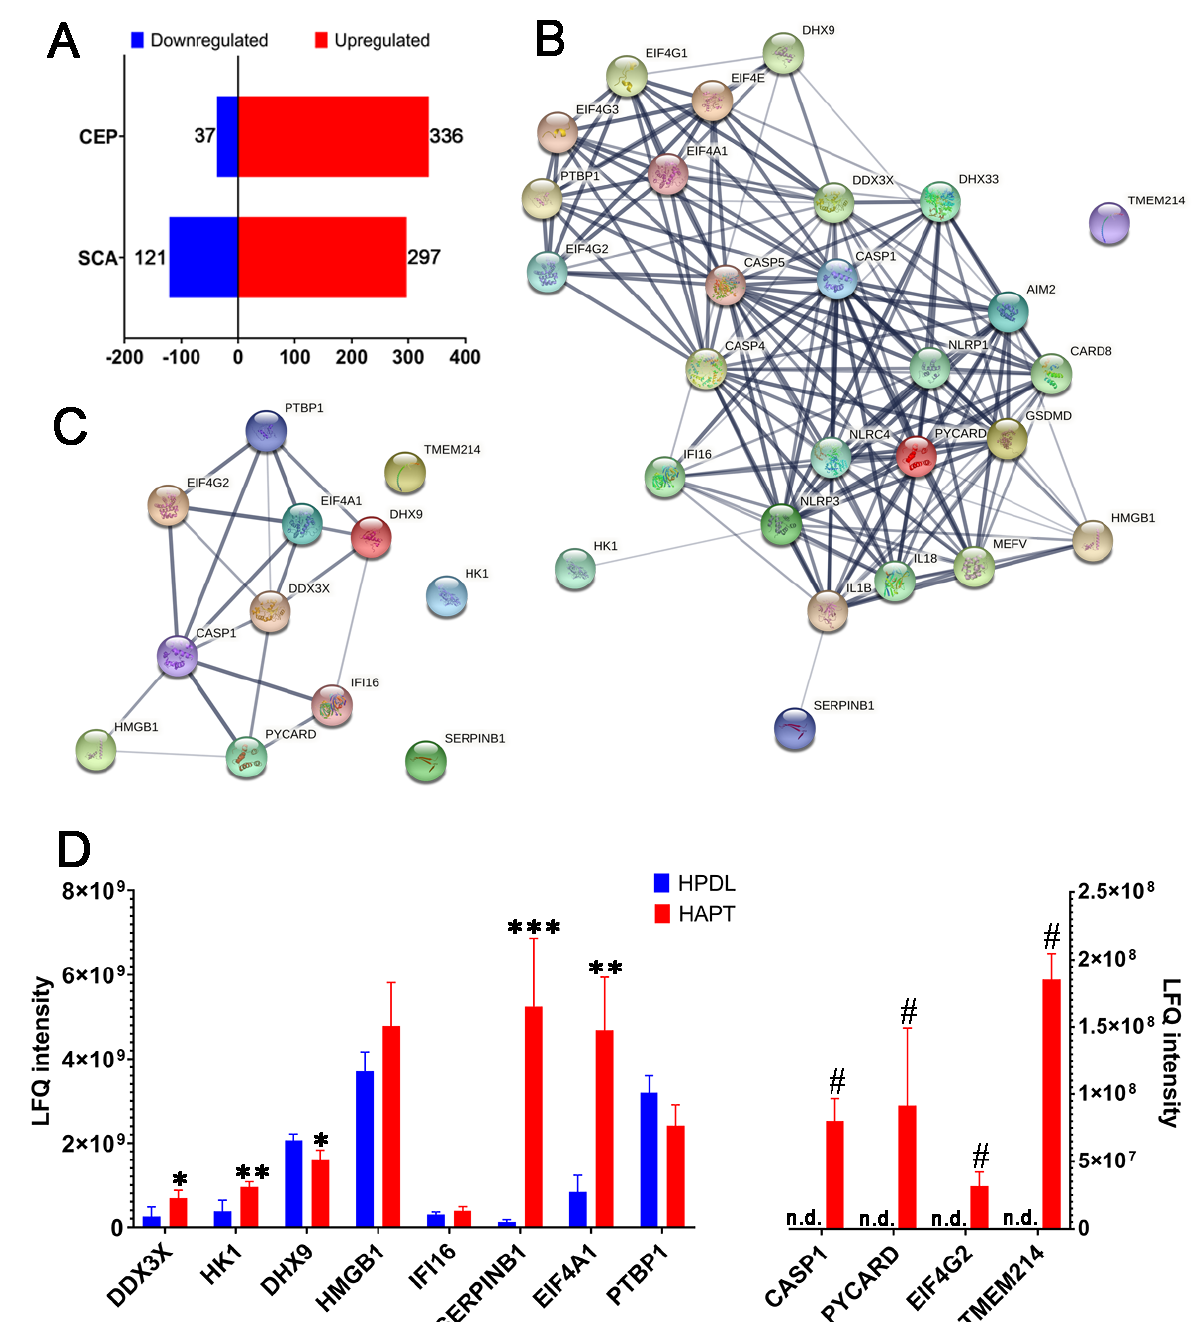
Figure 1. Caspase-1 and pyroptosis-related proteins in human apical periodontitis tissue (HAPT). ( A ) The number of SCA and CEP in HAPT and periodontal ligament tissue (HPDL). ( B ) The PPI network including all proteins possibly related to pyroptosis according to STRING. ( C ) The PPI network including proteins related to pyroptosis in our study. Caspase-1 is related to most other proteins. ( D ) The LFQ intensity of 12 proteins related to pyroptosis in our study was detected by label-free proteomics (*, p < 0.05; **, p < 0.01; ***, p < 0.001; #, proteins only detected in HAPT; n.d., not detected).